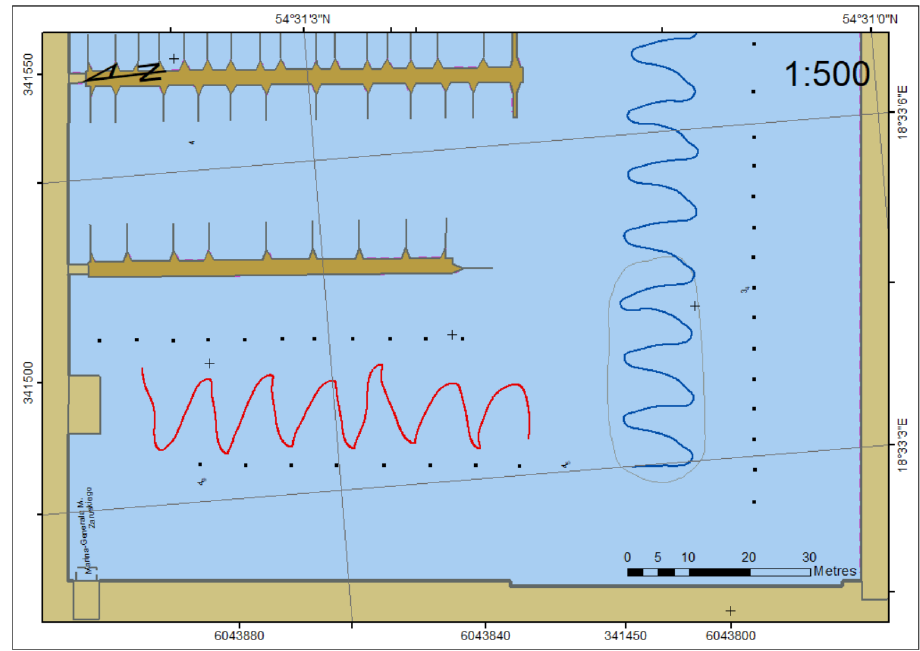
Figure 9. Trajectory of USV during measurements on short profiles with quick heading changes.